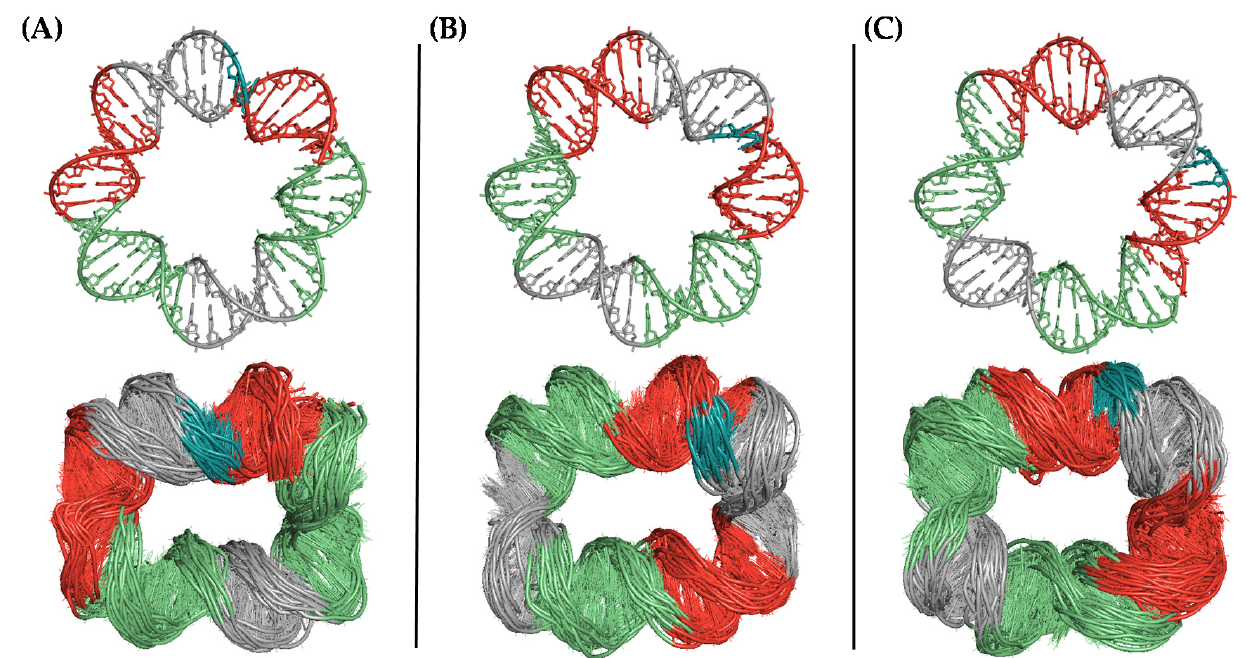
Figure 4. Conformational diversity of the DNA microcircle after uMD equilibration (bottom) depending on the register of the helix (( A ) no offset; ( B ) 5-bp offset; and ( C ) 7-bp offset) in the initial model (top). The nucleotides making up the sealed gap are colored in blue.